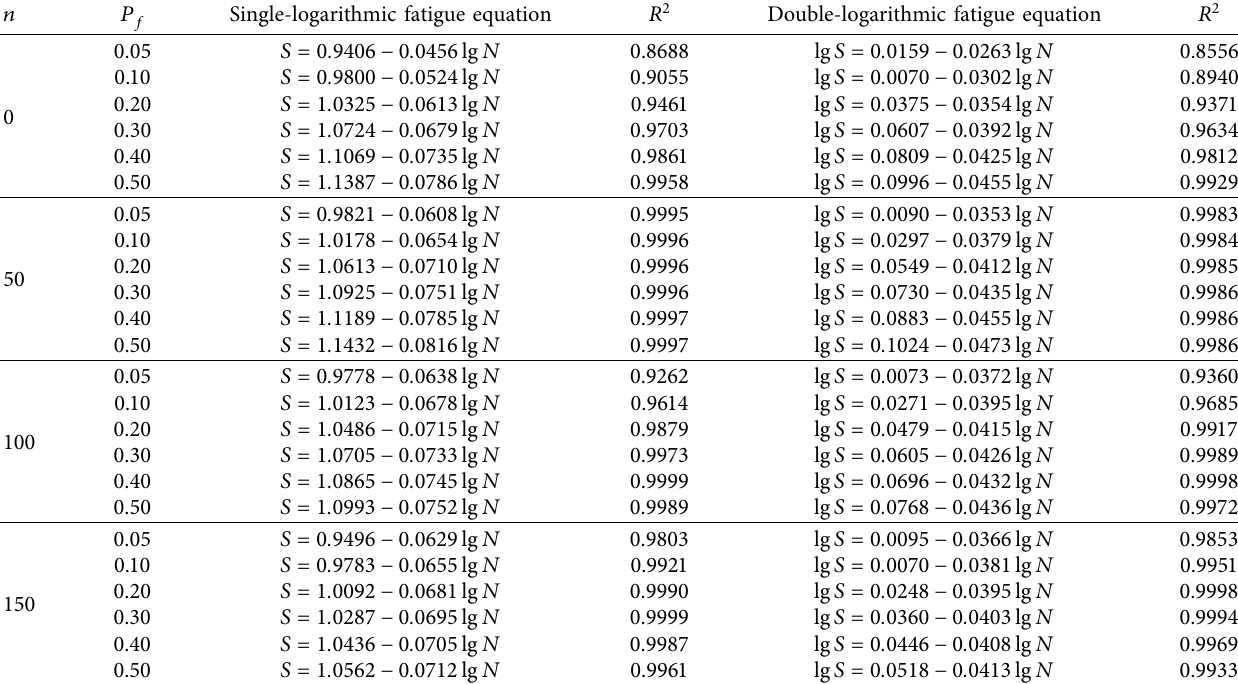
Table 12: Single-logarithmic and double-logarithmic fatigue equations of AASC with various degrees of frost damage for various failure